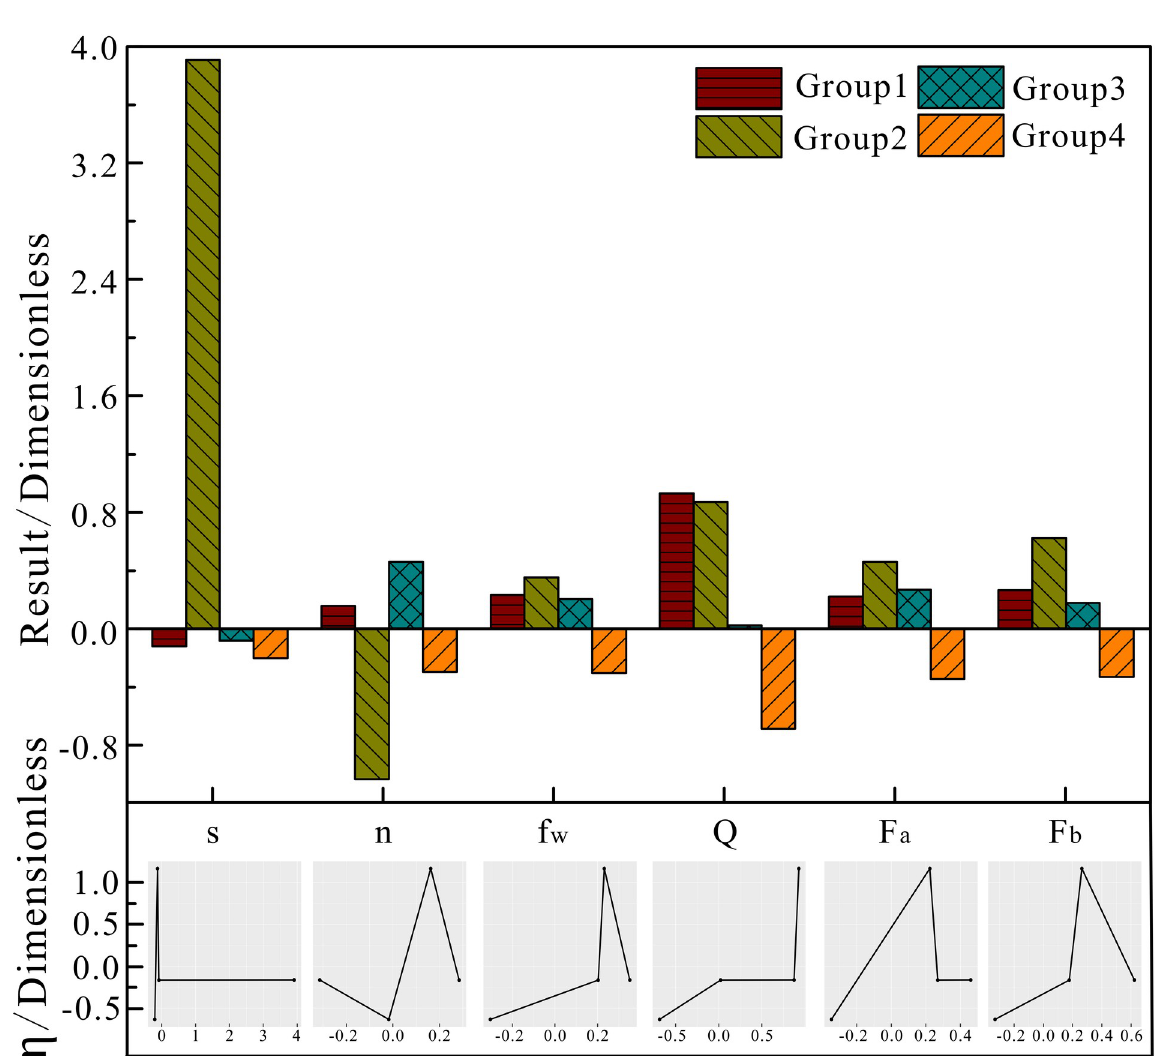
Fig 11. Block operating parameters of the improved algorithm clustering analysis.